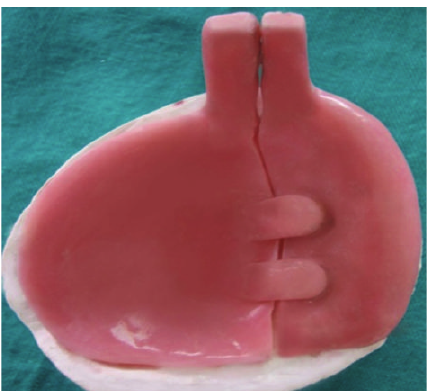
Figure 6: Custom sectional tray.